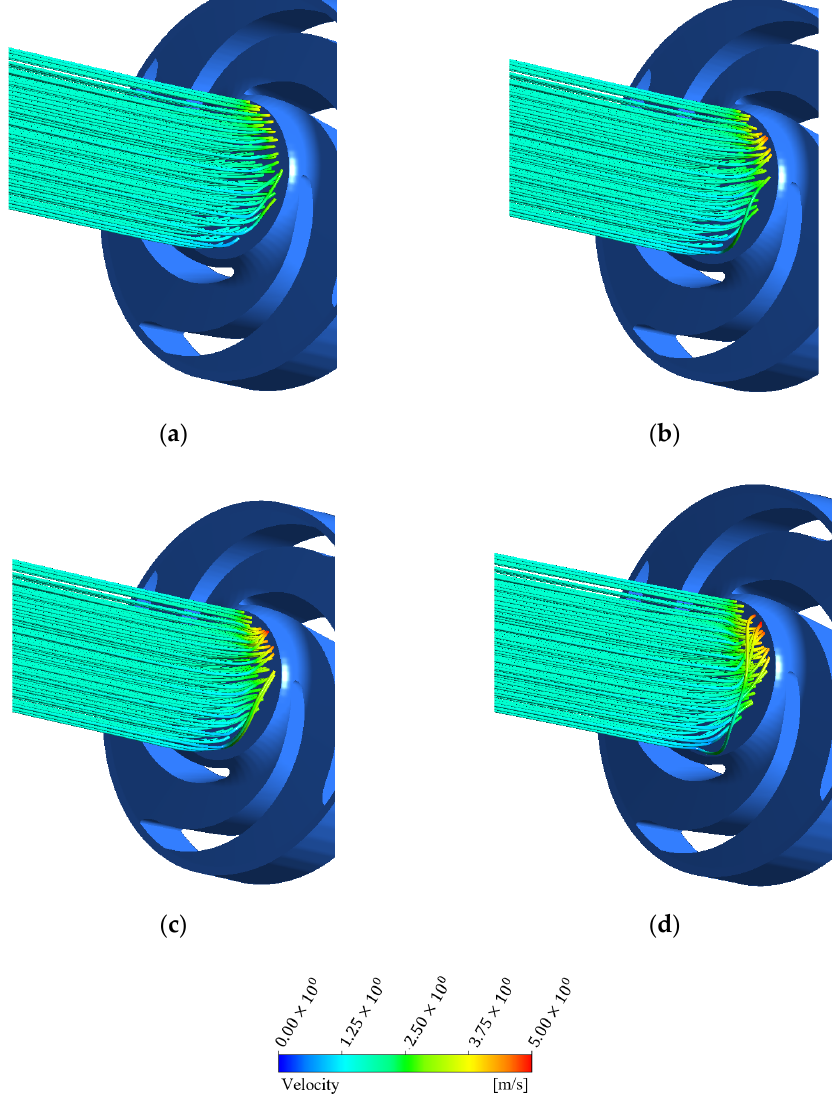
Figure 11. Velocity streamline distributions in the inlet section at different solid volume fractions under 1.0 Q BEP : ( a ) C V = 0%; ( b ) C V = 5%; ( c ) C V = 10%; ( d ) C V = 15%.